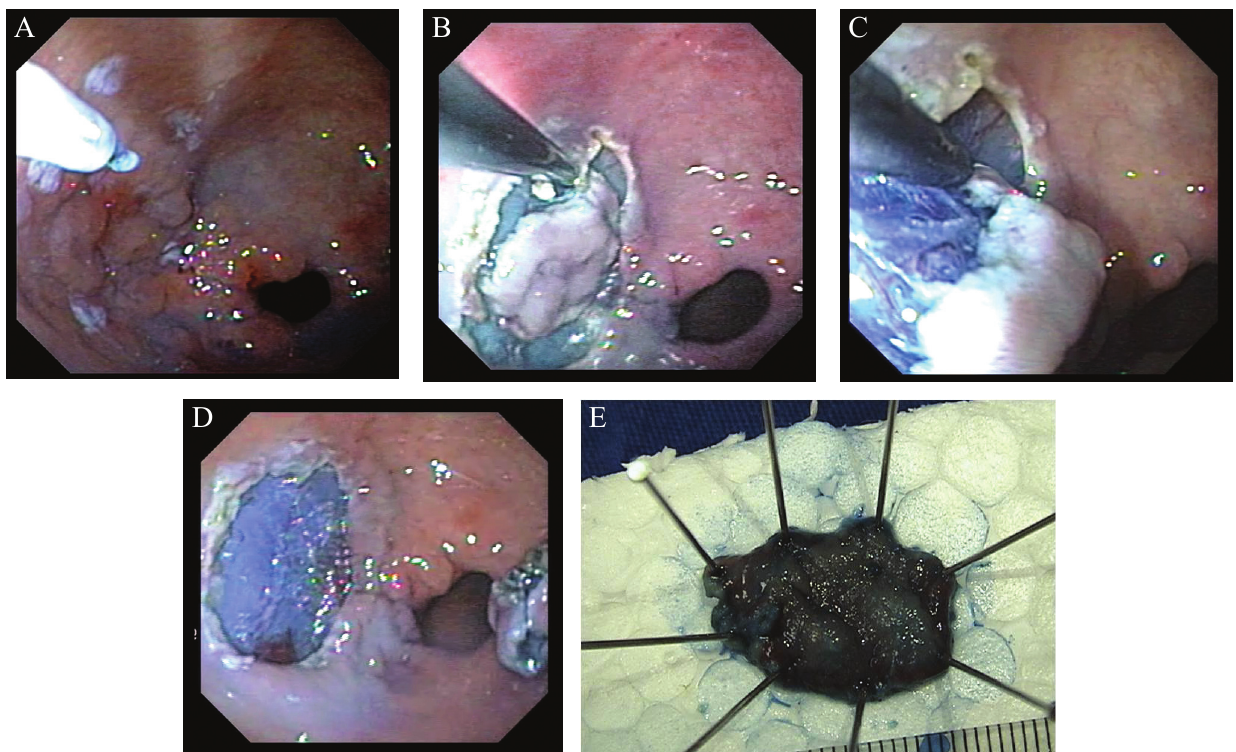
Figure 1 - Endoscopic submucosal dissection of a gastric adenocarcinoma (IIa+IIc). A- Marking of the lesion. B- Circumferential cutting around the entire lesion. C- Submucosal dissection of the lesion with the IT-knife. D- Complete resection of the lesion. E- ESD specimen (one